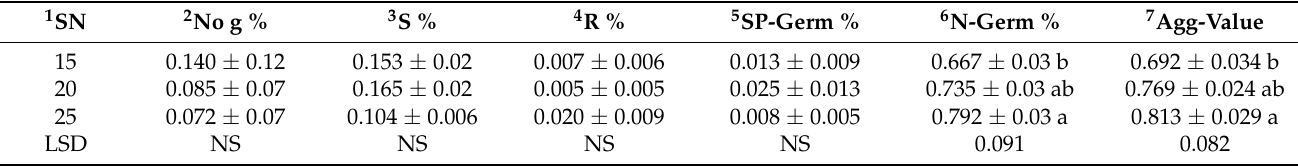
Table 3. Germination ratio and seedling characteristics of rapeseed as a response to the number of seeds per Petri dish.